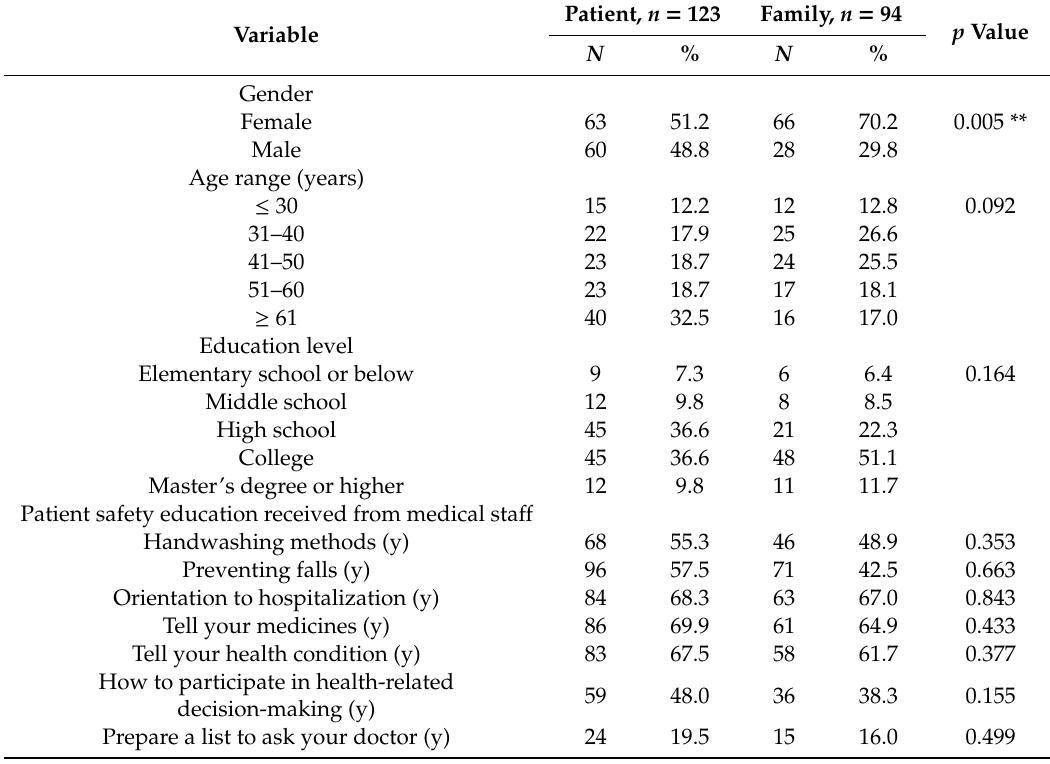
Table 2. Results of the homogeneity test between patients and